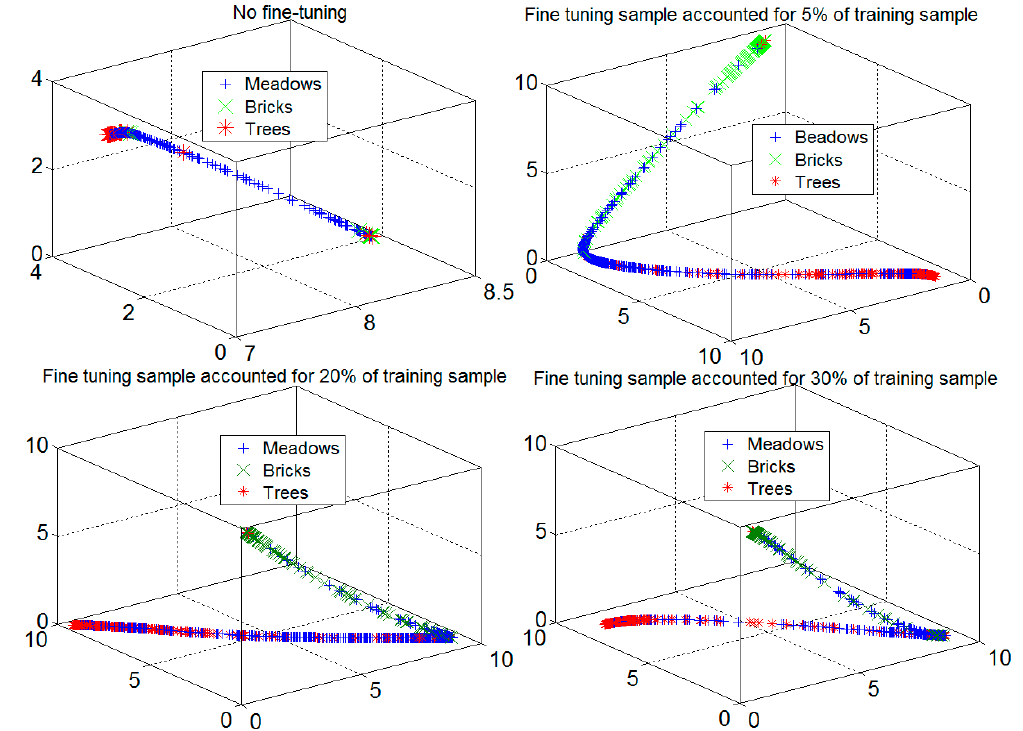
Figure 6. Chart of the divisibility of data changes with the labeled samples.